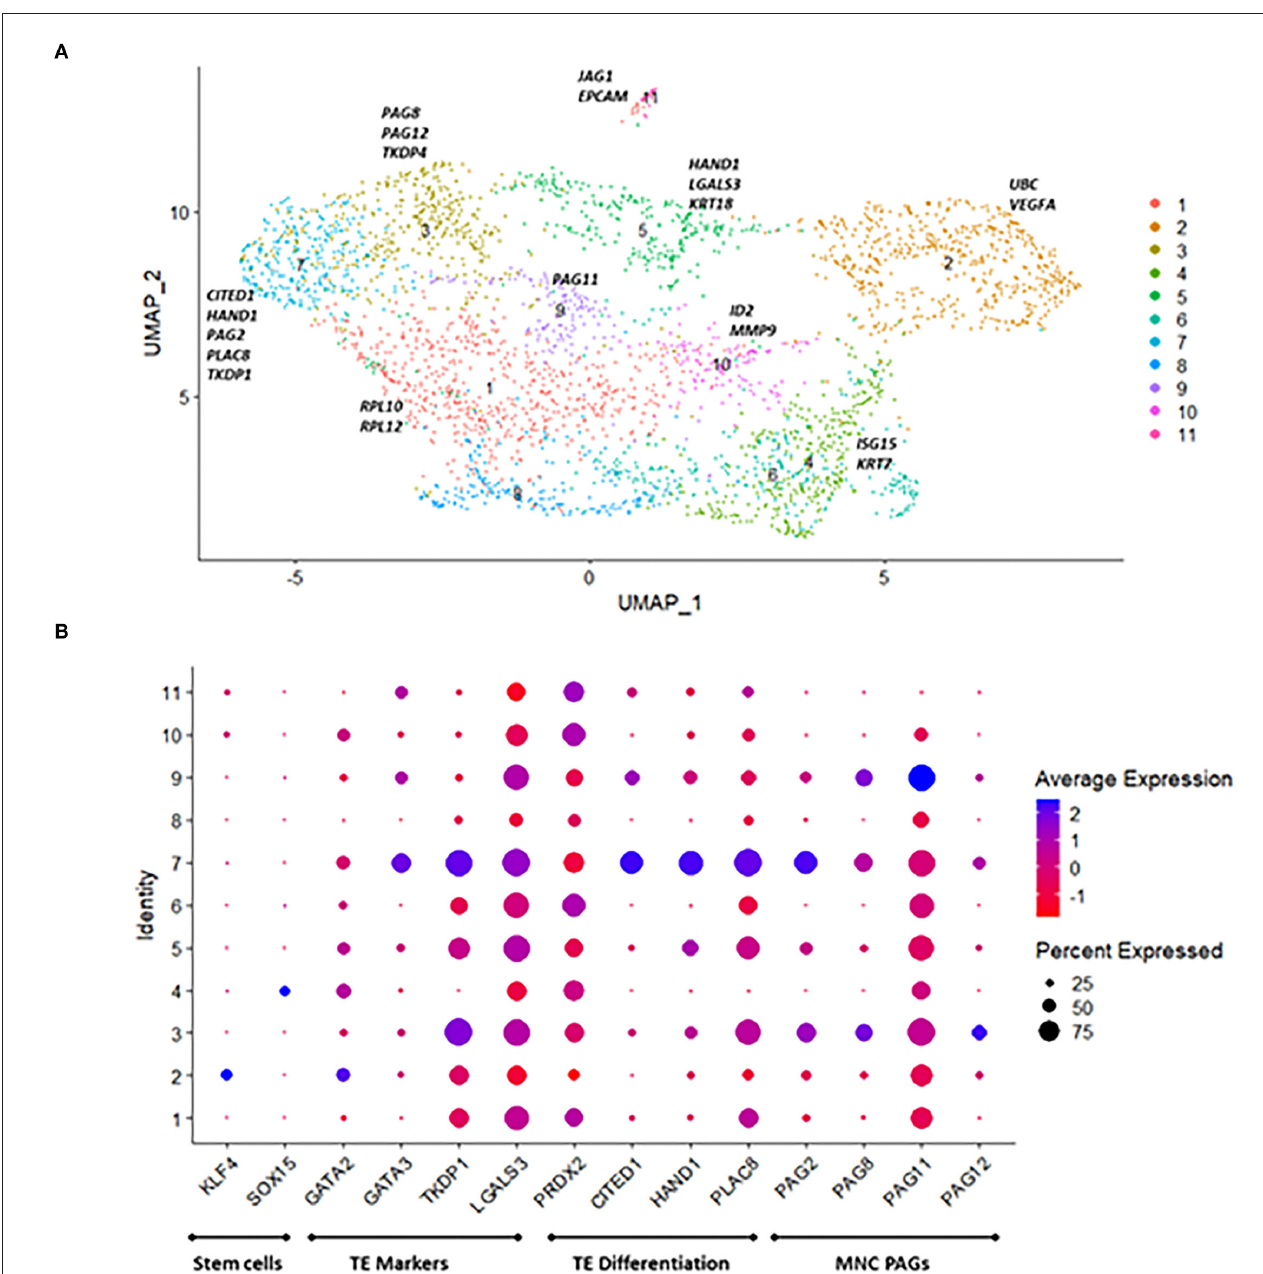
FIGURE 5 | Single-RNA seq profiling of in vitro derived trophectoderm (IVT) outgrowths on day 40. (A) UMAP plot revealing 11 cell populations based on marker gene analysis. (B) DotPlot representing genes involved in trophectoderm specification, differentiation, and PAGs. Dot Size indicates the percentage of cells in the cluster expressing the gene, and shading represents level of expression (higher expression = blue shade lower expression = red shade).